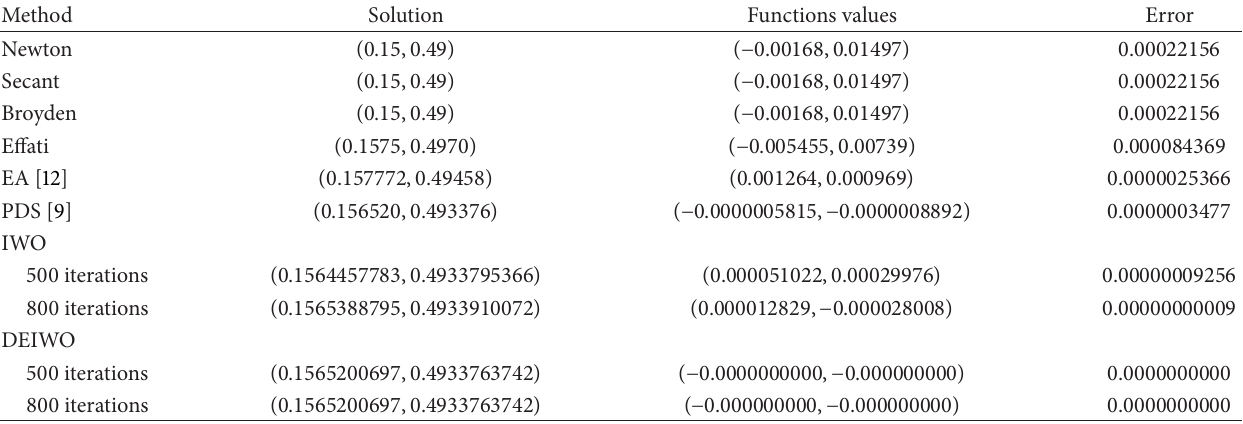
Table 4: Comparison of results for Example 1.